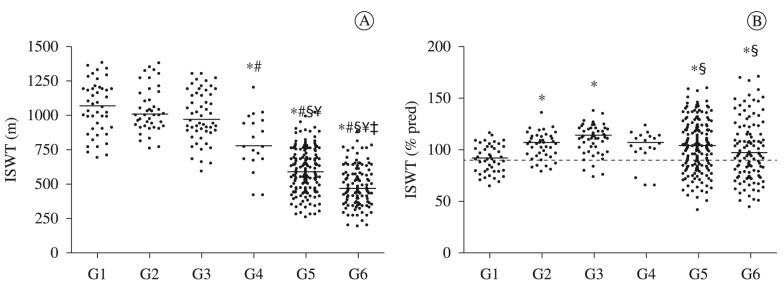
A) Incremental Shuttle Walking Test (ISWT) in all groups (G1-G6) presented
in meters (test with the largest distance walked); B) ISWT in all groups
(G1-G6) presented in percentage of predicted; G1: 18-29 years; G2: 30-39 years;
G3: 40-49 years; G4: 50-59 years; G5: 60-69 years; G6: ≥70 years;* p<0.05 vs
G1; # p<0.05 vs G2; § p<0.05 vs G3; ¥ p<0.05 vs G4; ‡ p<0.05 vs G5;
The dotted line (B) represents 90% of the predicted value for the ISWT.